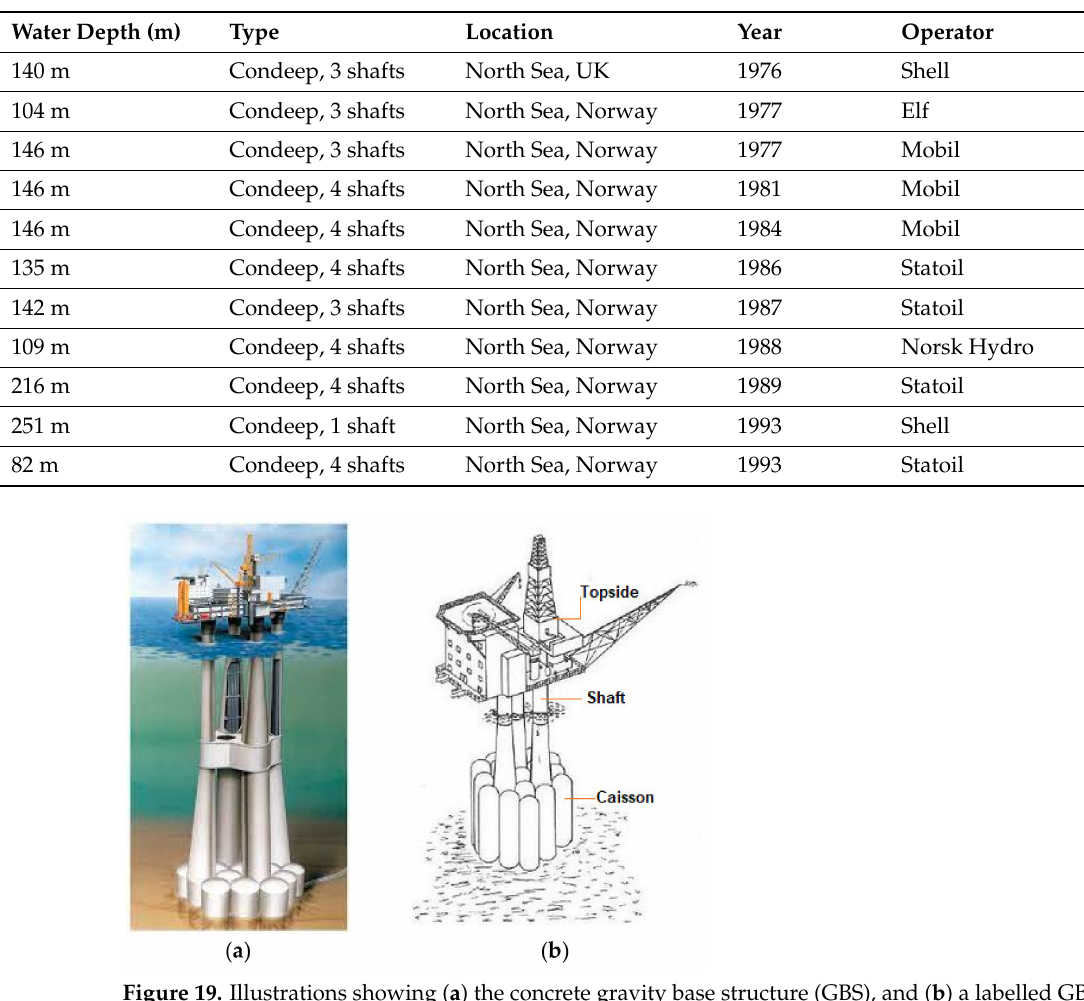
Figure 19. Illustrations showing ( a ) the concrete gravity base structure (GBS), and ( b ) a labelled GBS.